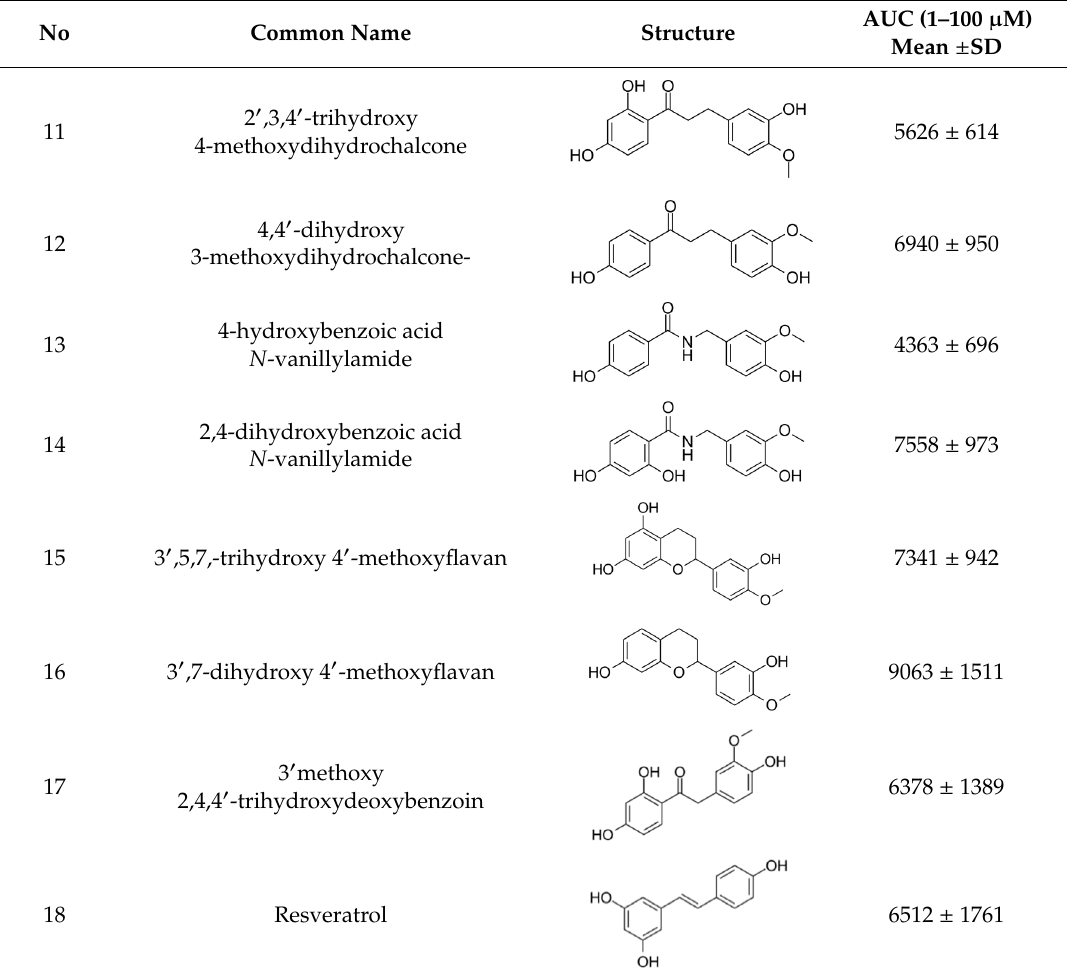
Figure 1. Cell vitality upon 6 h incubation of human gingival fibroblasts (HGF-1) cells with 10 ng/mL lipopolysaccharides (LPS) and 100 µM of the respective compound. Shown are average ±SD compared to untreated cells. The horizontal line marks the vitality of cells treated with 0.1% DMSO only. Significant differences between treatment and control were tested using the Student’s t -test.